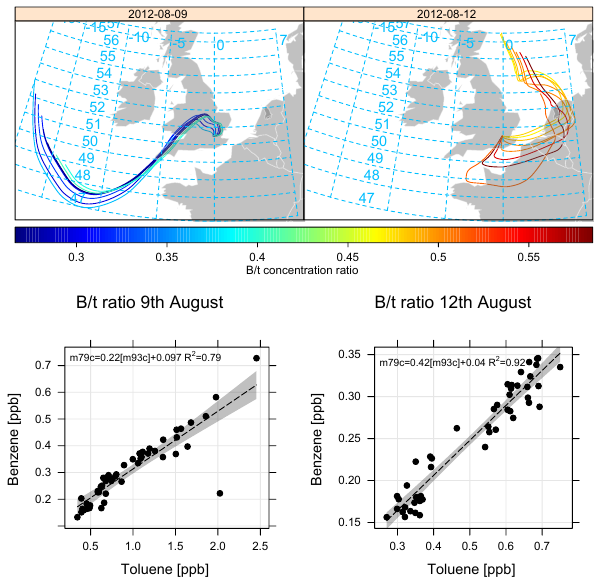
Figure 7. Top: 24h back trajectories from the NOAA HYSPLIT tra- jectory model during selected days in August 2012 corresponding to periods of low (left) and high (right) benzene/toluene concentra- tion ratios. Daily release in 3h intervals (10m height) for 24h prior. Bottom: scatter plots showing benzene-to-toluene concentration ra- tios during 9 August 2012 (left) and 12 August 2012 (right) with linear regression with 95th confidence interval, regression equation and coefficient ( R 2